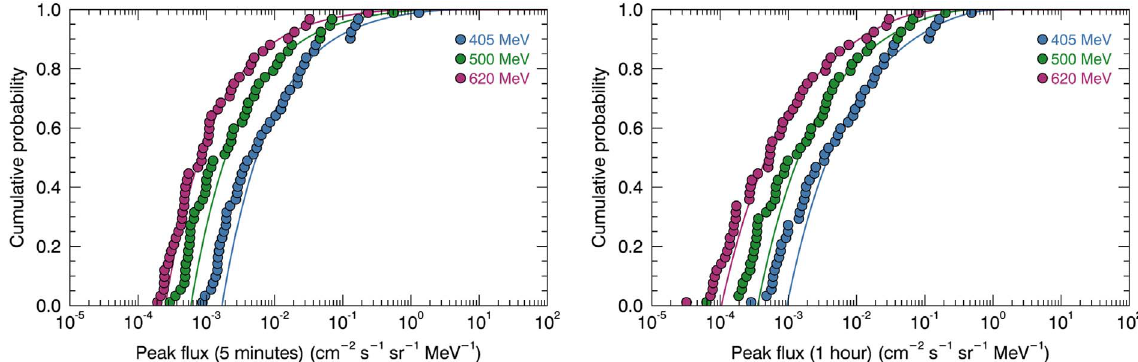
Fig. 4. Distribution of 5 min (left) and 1 h (right) peak fl uxes of SEP episodes. The lines show the fi tted cut-off power law functions.